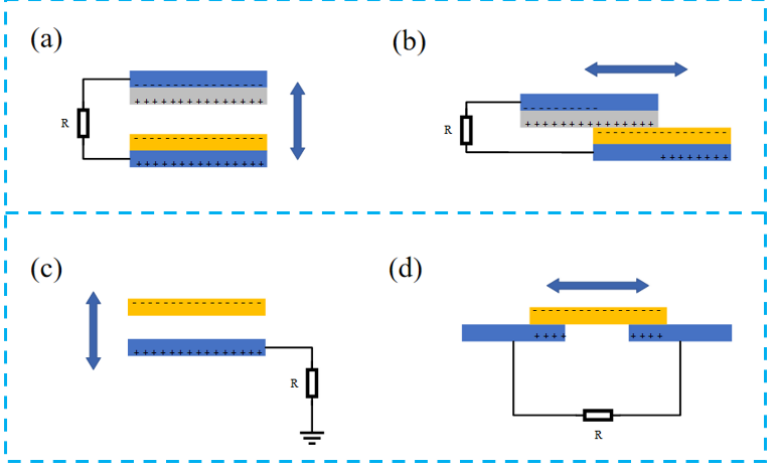
Figure 2. Four fundamental modes of TENG: ( a ) vertical contact-separation mode, ( b ) lateral sliding mode, ( c ) single-electrode mode, and ( d ) freestanding triboelectric-layer